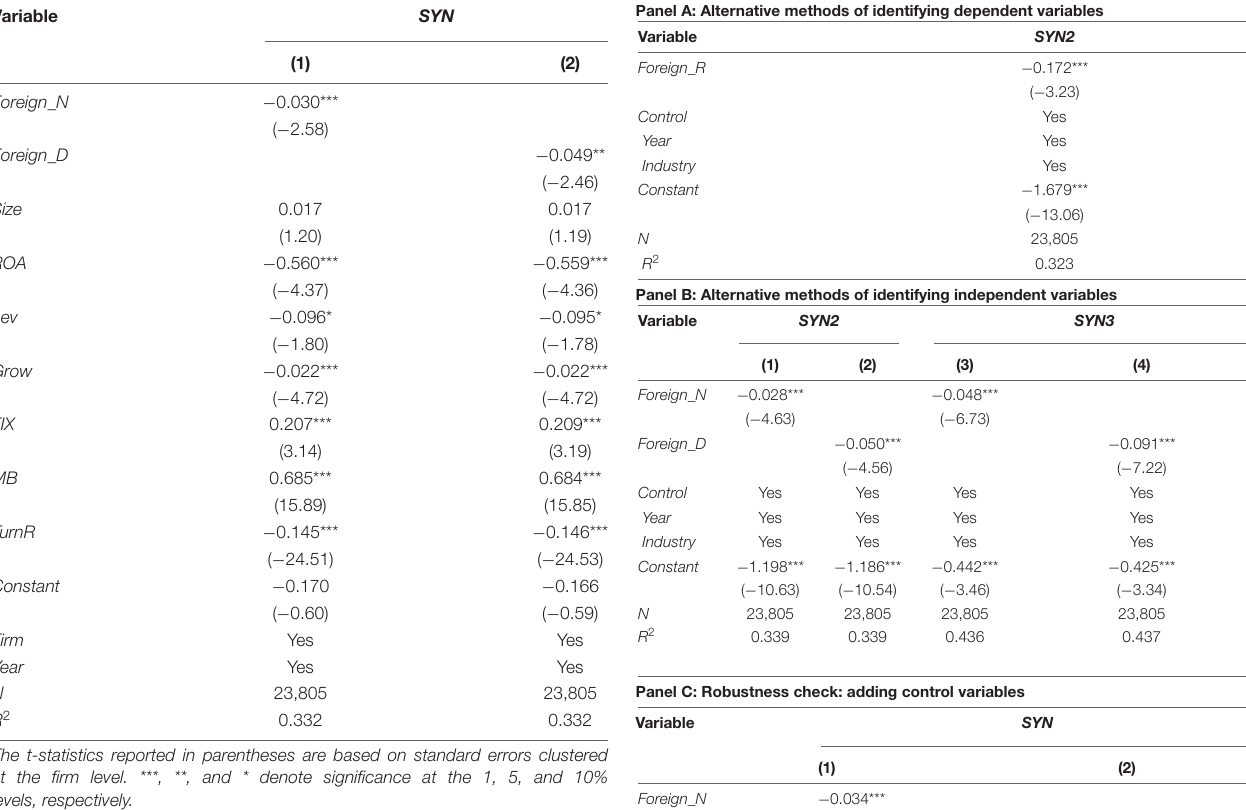
TABLE 9 | Firm fixed effect model. TABLE 10 | Robustness